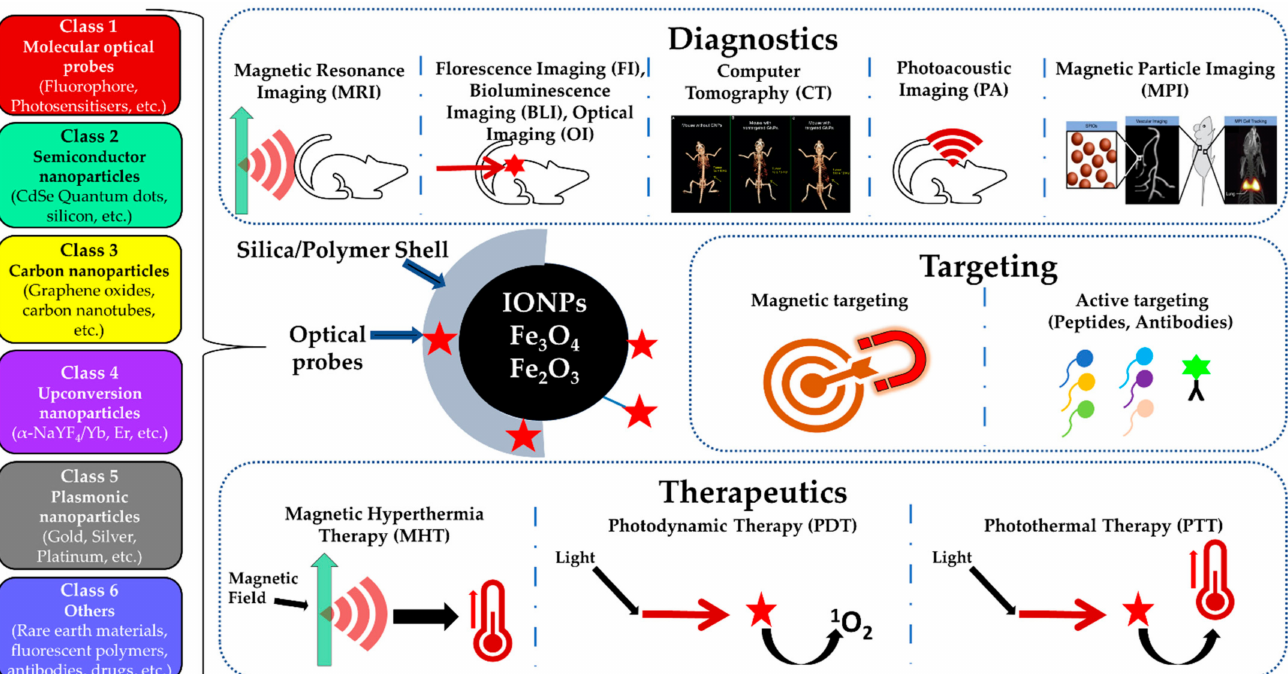
Figure 1. Schematic representation depicting iron oxide-optical probe conjugated nanocomposites for various in vivo biomedical applications. Different colors in the left represent different classes of optical probes. Green arrow indicates the magnetic field, red waves indicate the radiation, red stars indicate optical probe and thermometer symbols indicate temperature elevation due to